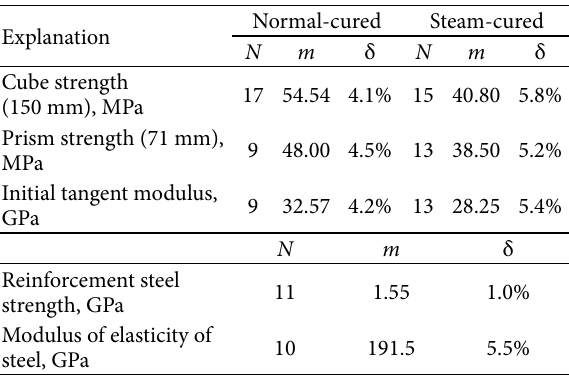
Fig. 2. Experimental set-up of the prisms and the beams (Дулинскас 1973)